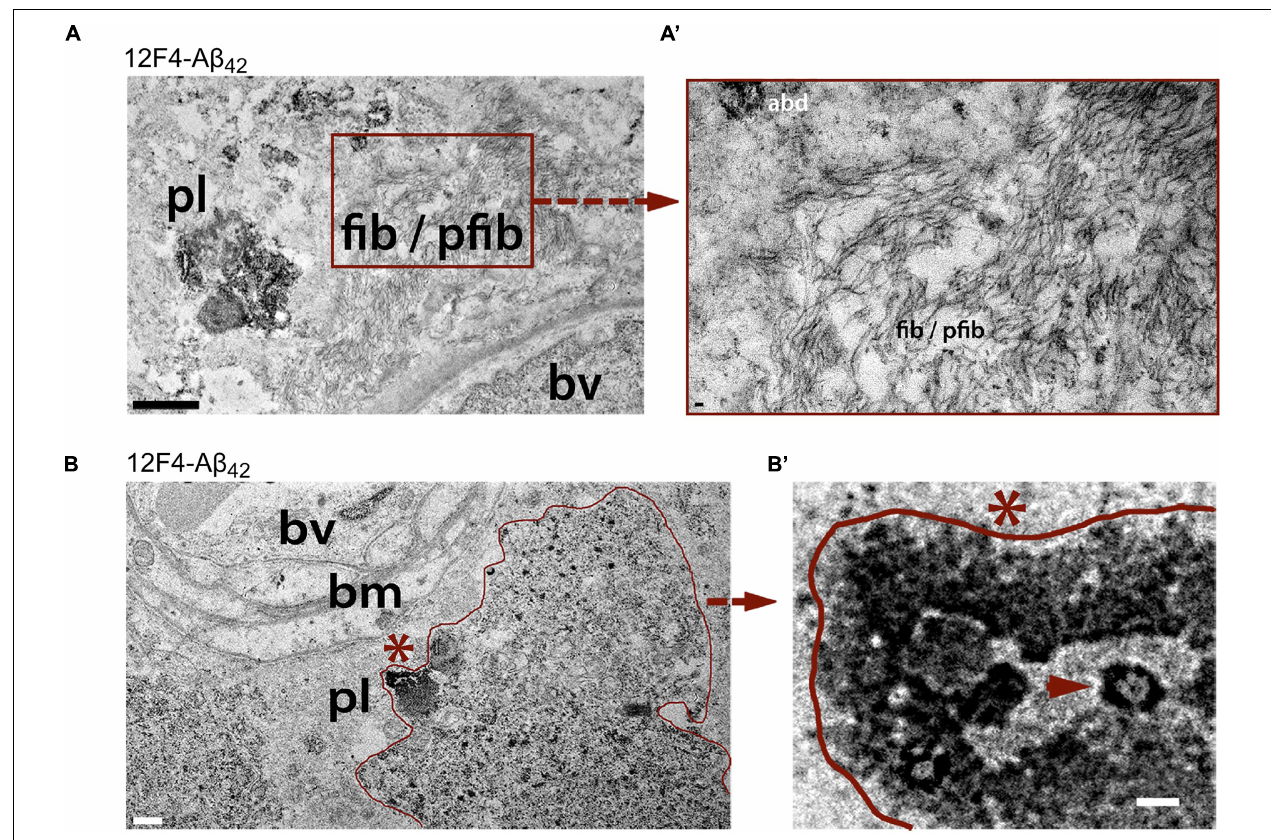
FIGURE 3 | Ultrastructure of A β deposits in AD retina identified by transmission electron microscopy (TEM). (A–B’) Representative TEM images of retinal cross-sections from definite AD patients showing (A) ultrastructure of A β plaque (pl), fibrils (fib) and protofibrils (pfib) near a blood vessel (bv). Scale bar: 1 µ m. (A’) High-magnification image showing A β fibrils, protofibrils and A β deposits (abd). Scale bar: 50 nm. (B) A β plaque-like deposits (pl; demarcated by red line), near basement membrane (bm) of a blood vessel (bv). Scale bar: 0.5 µ m. (B) High magnification image of region marked by red asterisk in (B) showing dense A β deposition with structural similarity to annular oligomers (red arrowhead). Scale bar: 40 nm. All sections were prestained with anti-A β 42 mAb (12F4) and peroxidase-based system and DAB substrate chromogen. Reproduced from Koronyo et al. (2017) with permission of ASCI via Copyright Clearance Center.